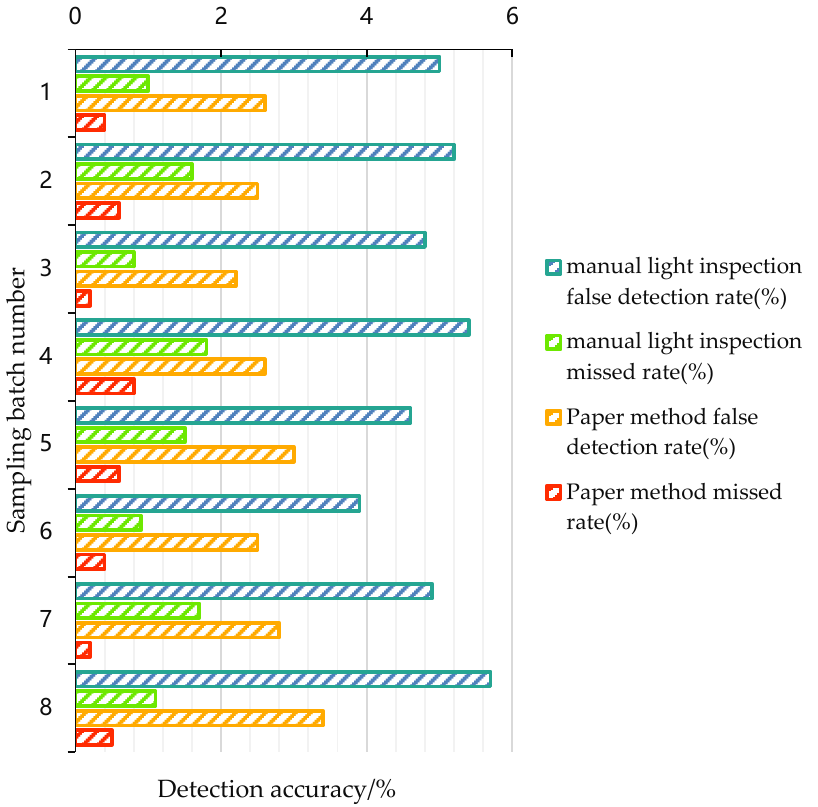
Figure 20. Accuracy results of the algorithm in this paper and manual lamp inspection.